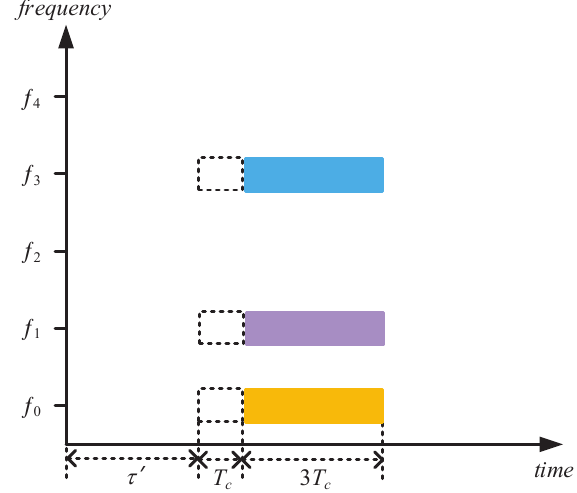
Figure 2. Time–frequency diagram of jammer’s transmitted